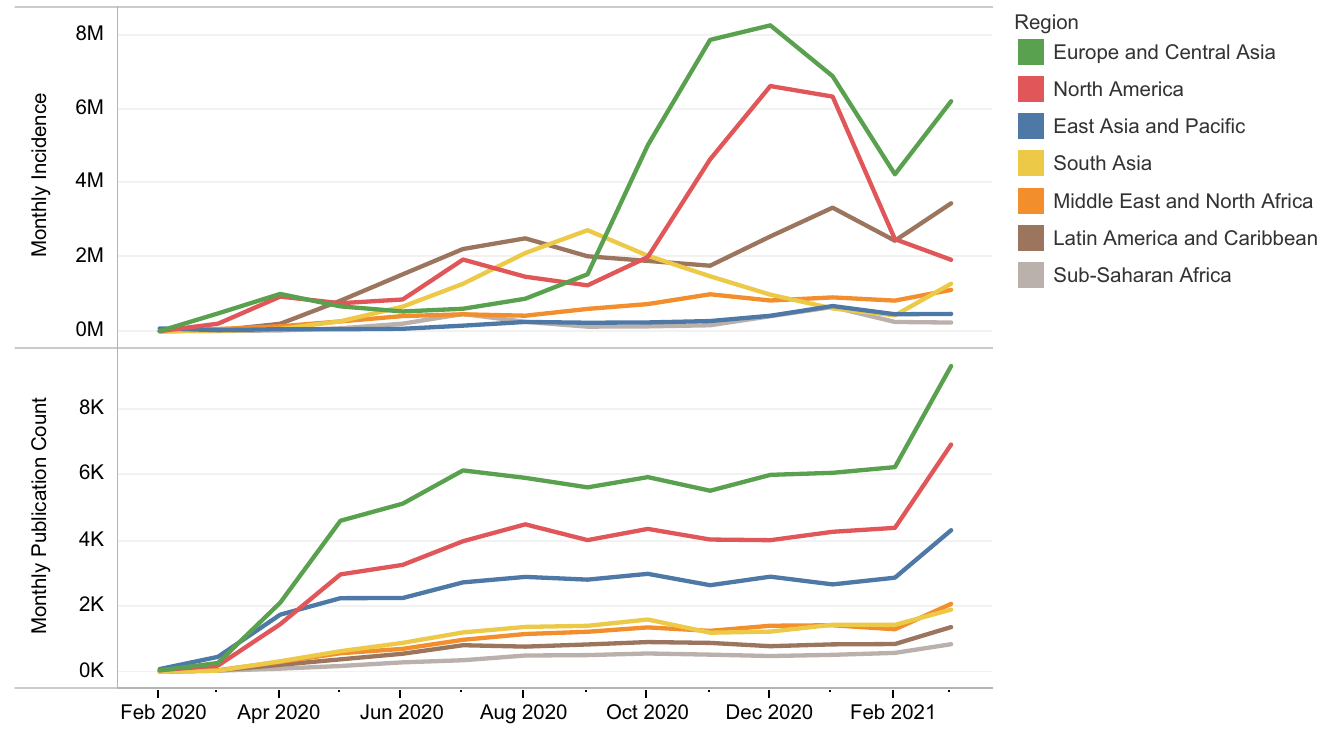
Fig 2. Monthly trends of global COVID-19 incidence and publications for each World Bank